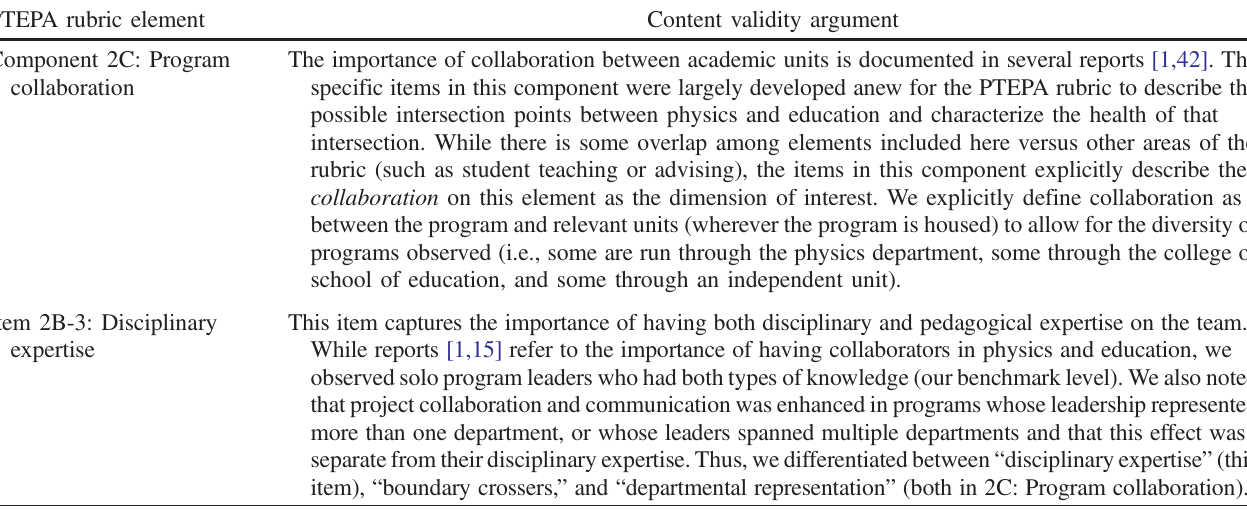
TABLE III. Sample validation of rubric components and